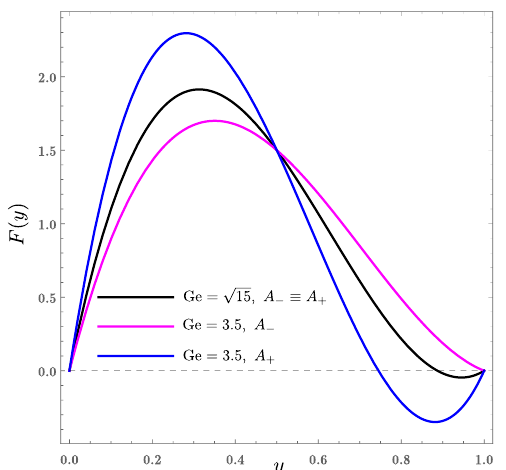
Figure 2. Plots of the velocity profile, function F ( y ) , for the dual branches A − and A + and different values of Ge.